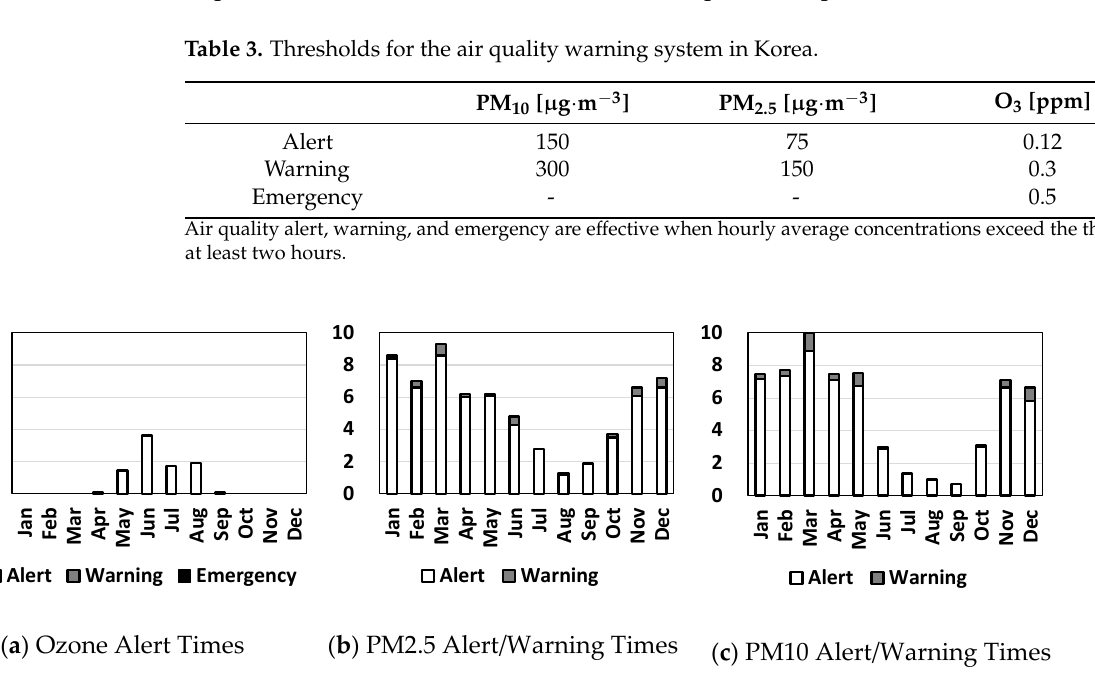
Figure 5. Monthly average numbers for alerts, warnings, and emergency alarms in each year between 2008 and 2018 for PM 10 , PM 2.5 , and O 3 in ( a – c ), respectively.